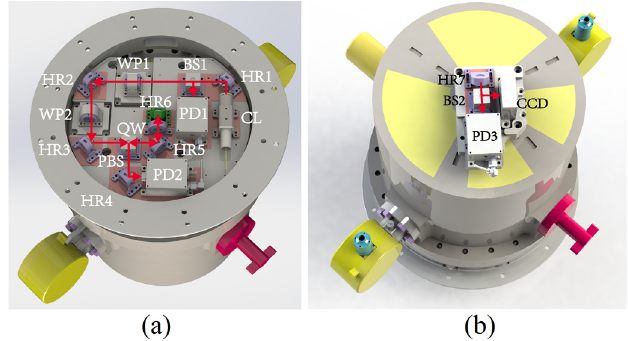
Figure 3. Optical systems ( a ) in front of the FP cavity and ( b ) behind the FP